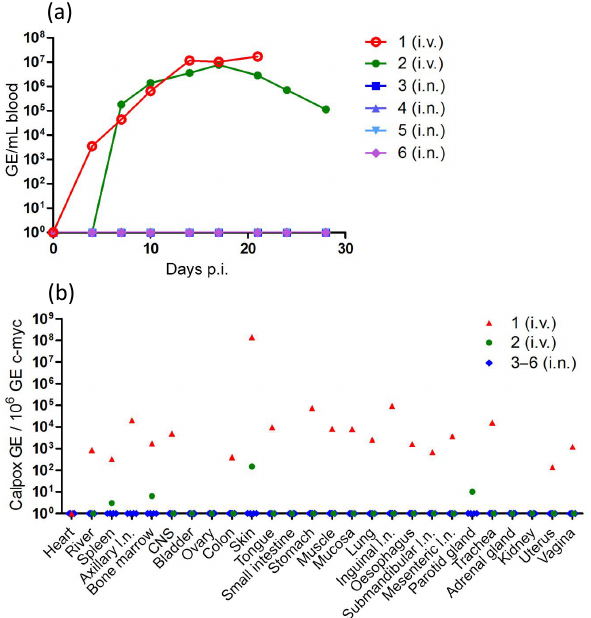
Figure 2. Detection of calpox DNA in blood and tissues of infected animals. (a) At different time points post-infection (see materials and methods), blood samples were taken, DNA was prepared from whole blood and viral DNA was determined with a specific qPCR assay. Genome equivalents (GE) for viral DNA were calculated per mL of blood. (b) Viral load in tissue. Post-mortem samples from various tissues were collected and DNA was isolated. Viral genome equivalents were determined by q-PCR and correlated to 10 6 copies of the c- myc